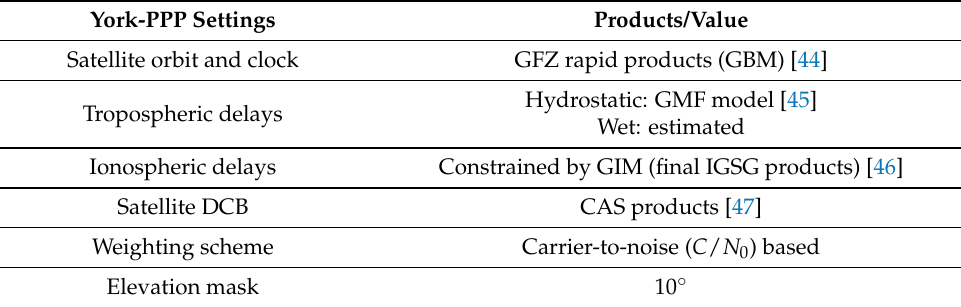
Table 1. York-PPP setting and corresponding